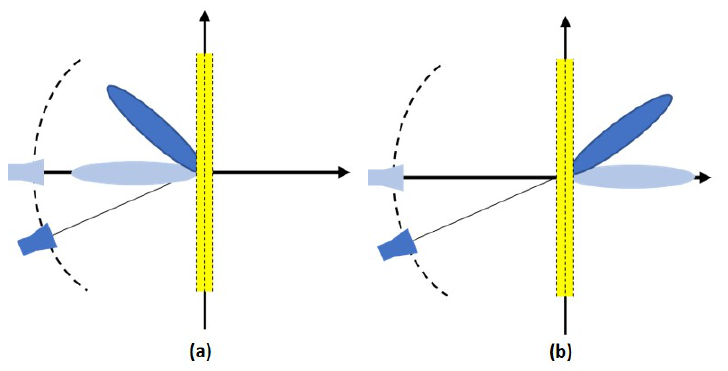
Figure 8. Feed displacement technique in ( a ) reflectarrays and ( b )